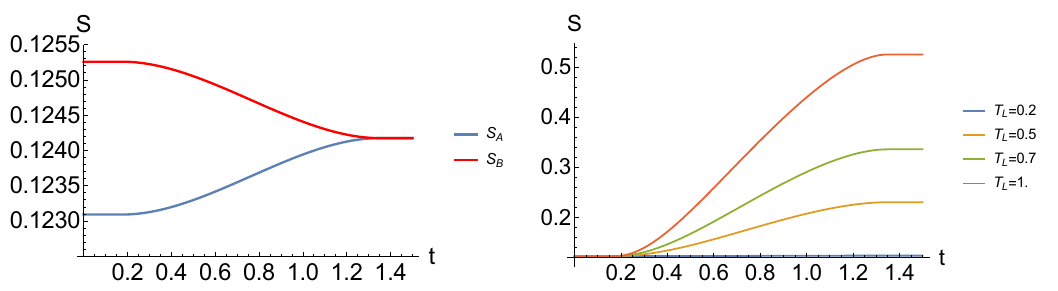
Figure 12 . Comparison of entanglement entropies for intervals A and B at temperatures T L = 0 : 2 T R = 0 : 195 (left panel), and entanglement entropies for the interval A in di(cid:11)erent temperatures | with T R = 0 : 195 and T L ranging from 0 : 2 (blue curve) to 1 : (orange) as functions of boundary time t . The left panel shows exact matching with previous results from (cid:12)gure 7, which is a consistency check. The right panel shows how the evolution changes when one gradually increases the temperature of one of the heat baths. All lengths in units of AdS 3 radius ( L =